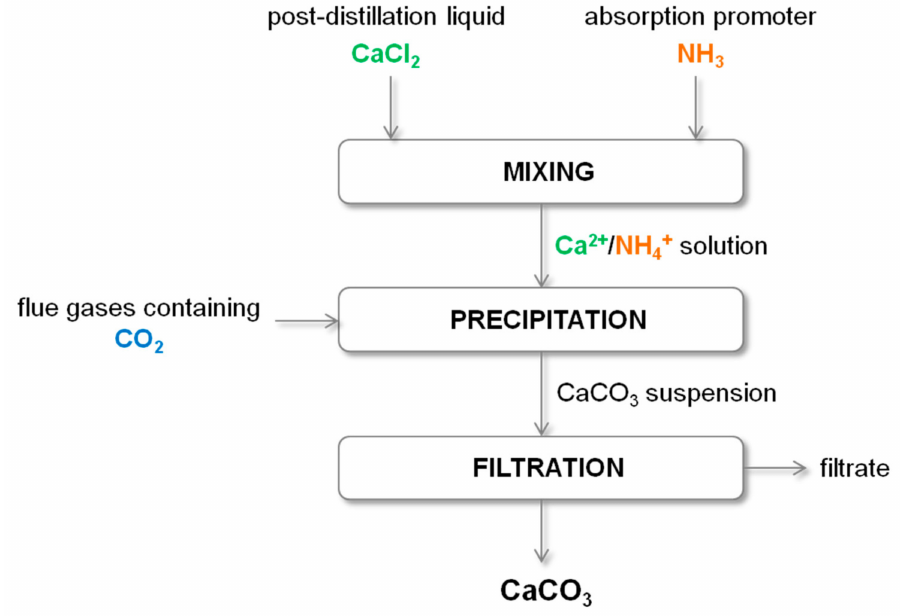
Figure 3. Diagram of the CaCO 3 precipitation process by the gas-liquid method using post-distillation liquid from the Solvay process and CO 2 from flue